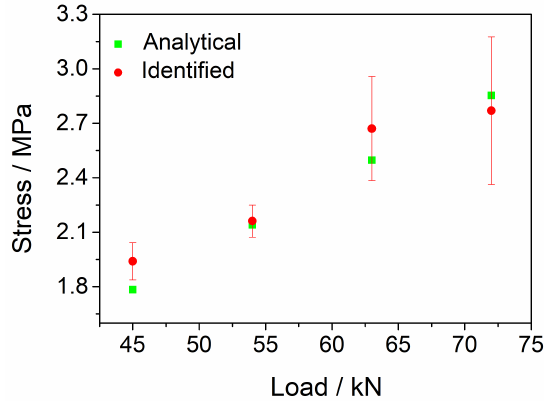
Figure 6. The average identified load results of three different